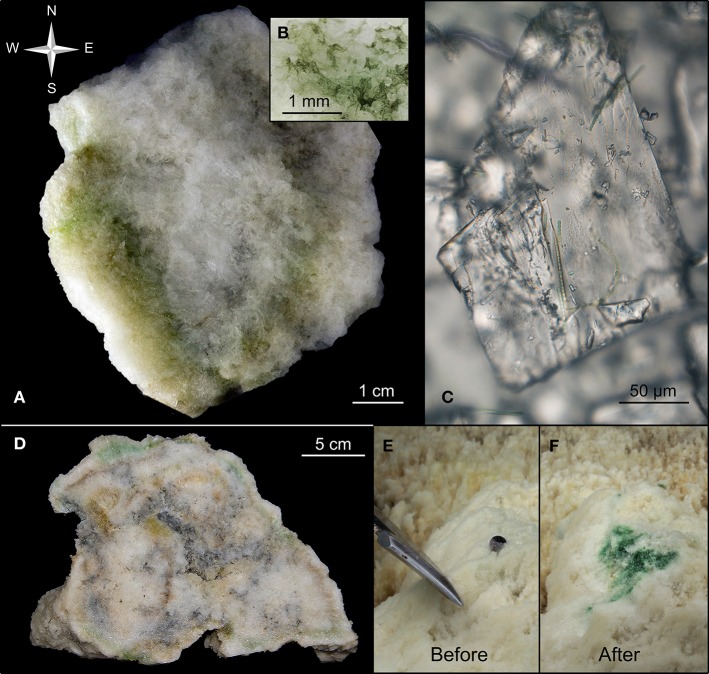
Biofilm layers in ikaite. (A) Cross-section of an ikaite column with dense green and yellowish bands of various thickness along the surface, (B) close-up of biofilm, (C) close-up of ikaite crystal with filamentous cyanobacteria, (D) cross-section of several ikaite columns fused together, with dense green and yellowish bands along the surface, (E,F)
In situ exposure of green biofilm in ikaite. (E) Intact ikaite surface with the tip of a knifeblade. (F) Sub-surface pigmented layer and small gas bubbles revealed after the outermost ~15 mm thick ikaite layer was scraped of.